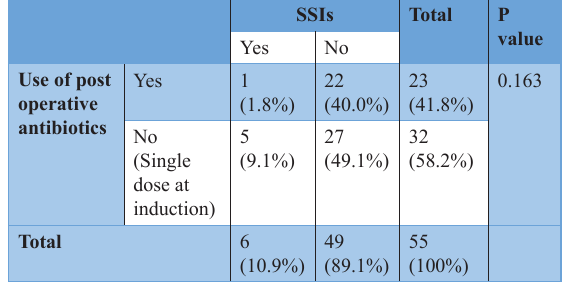
Table 4. Surgical site infection (SSIs) and use of post operative in patients with bile